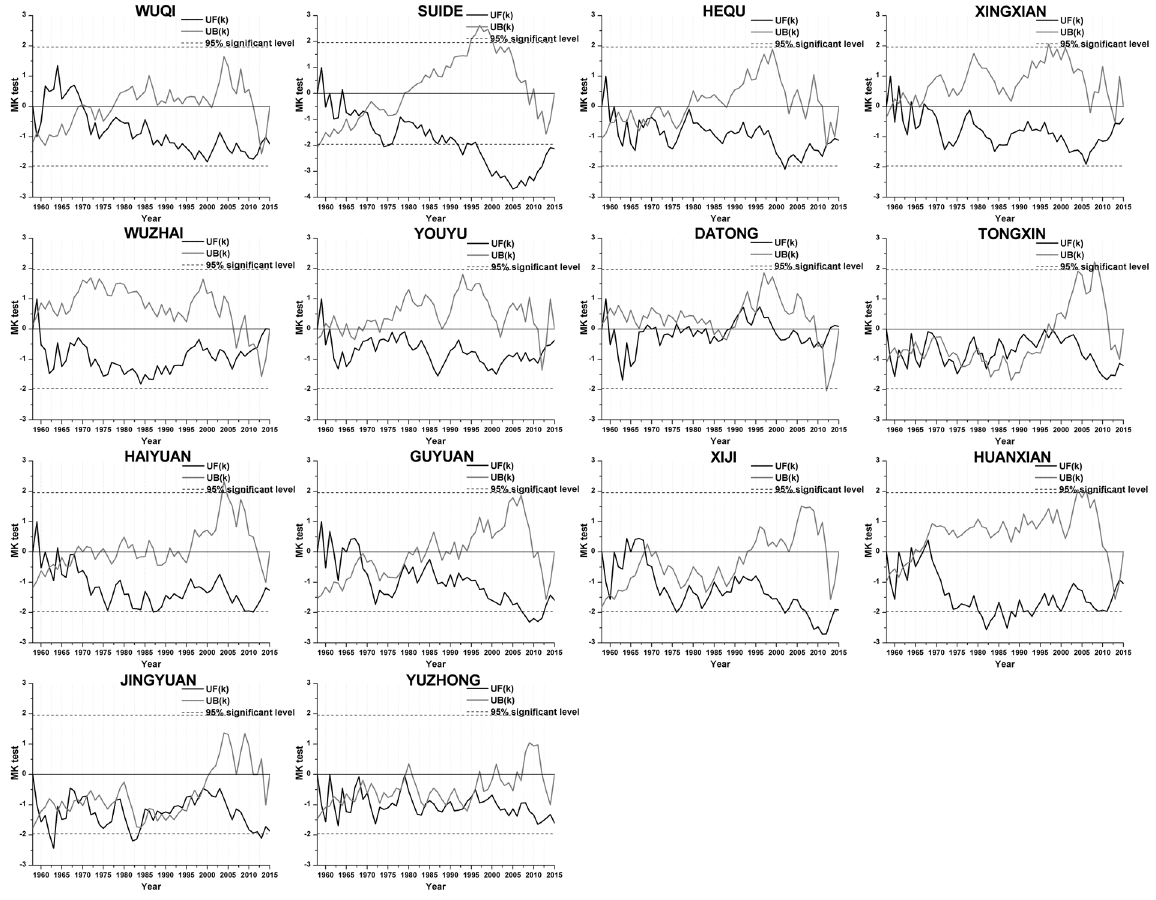
Figure 6. M-K trend test of annual